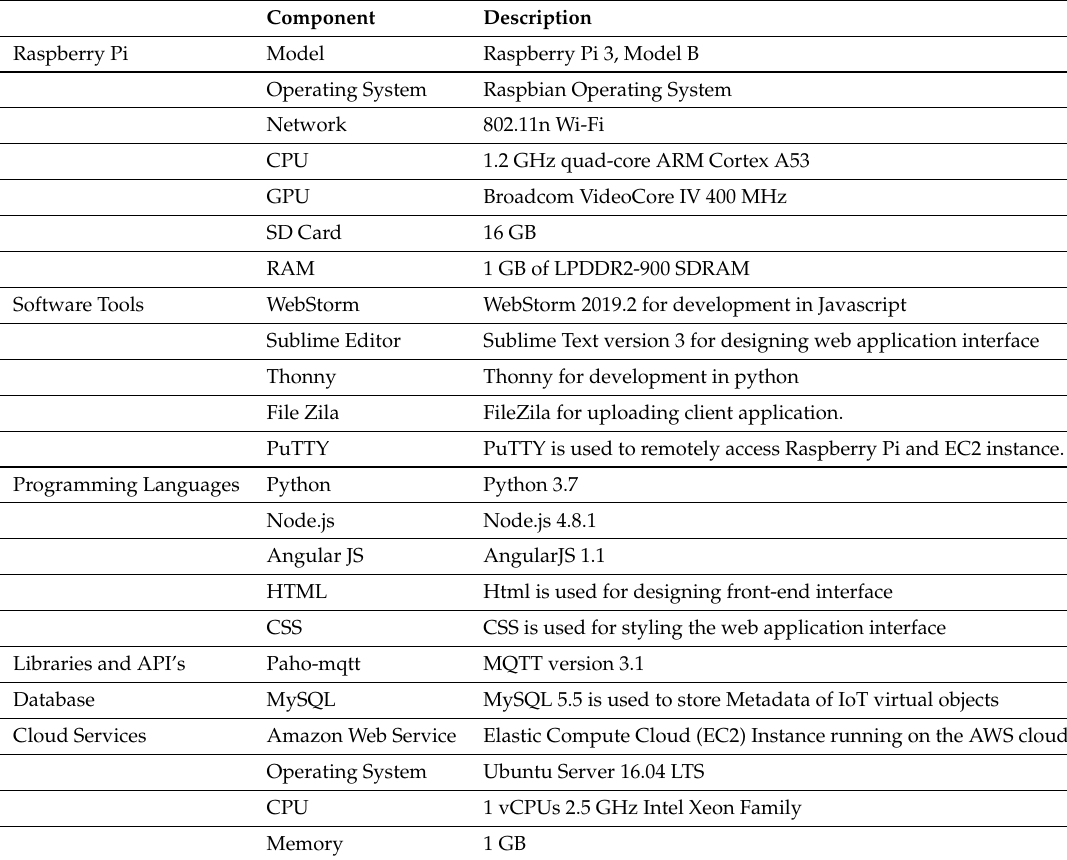
Table 1. Hardware and software services used in experimental